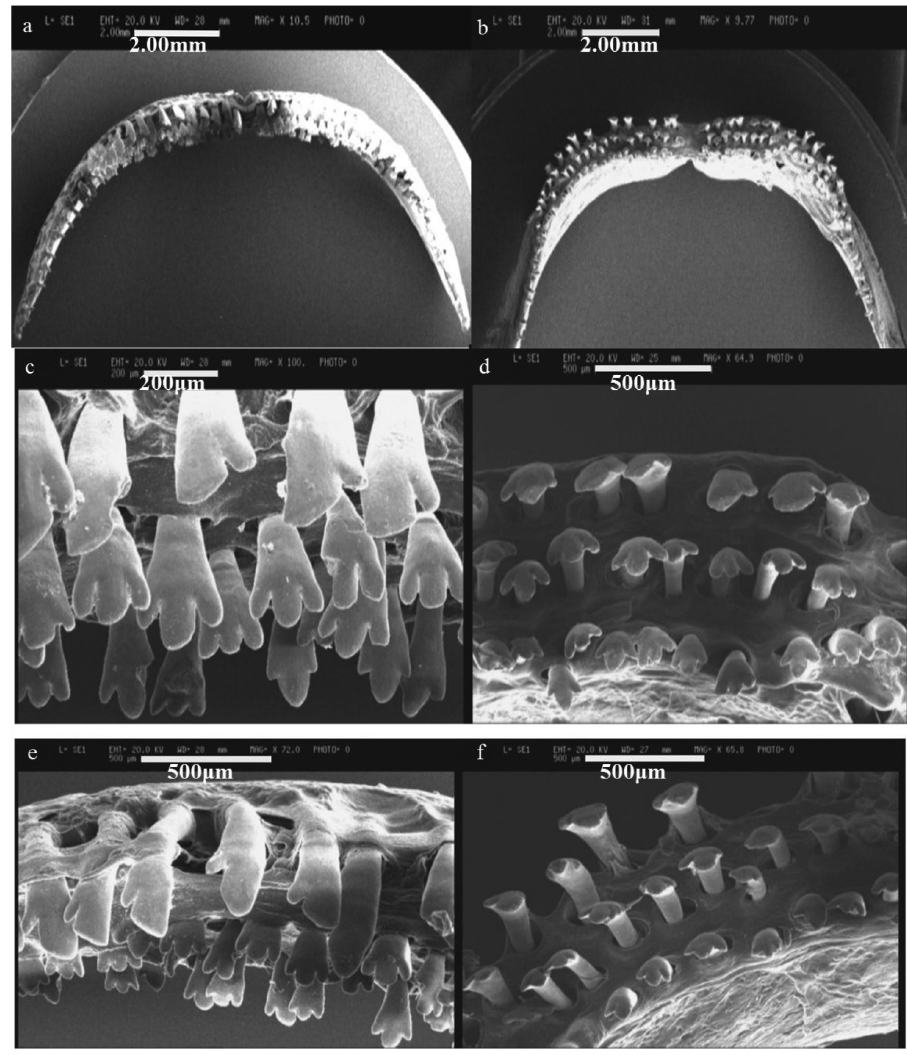
Figure 7. SEM photos of jaw teeth of Iranocichla persa ; a, c, e upper jaw b, d, f lower